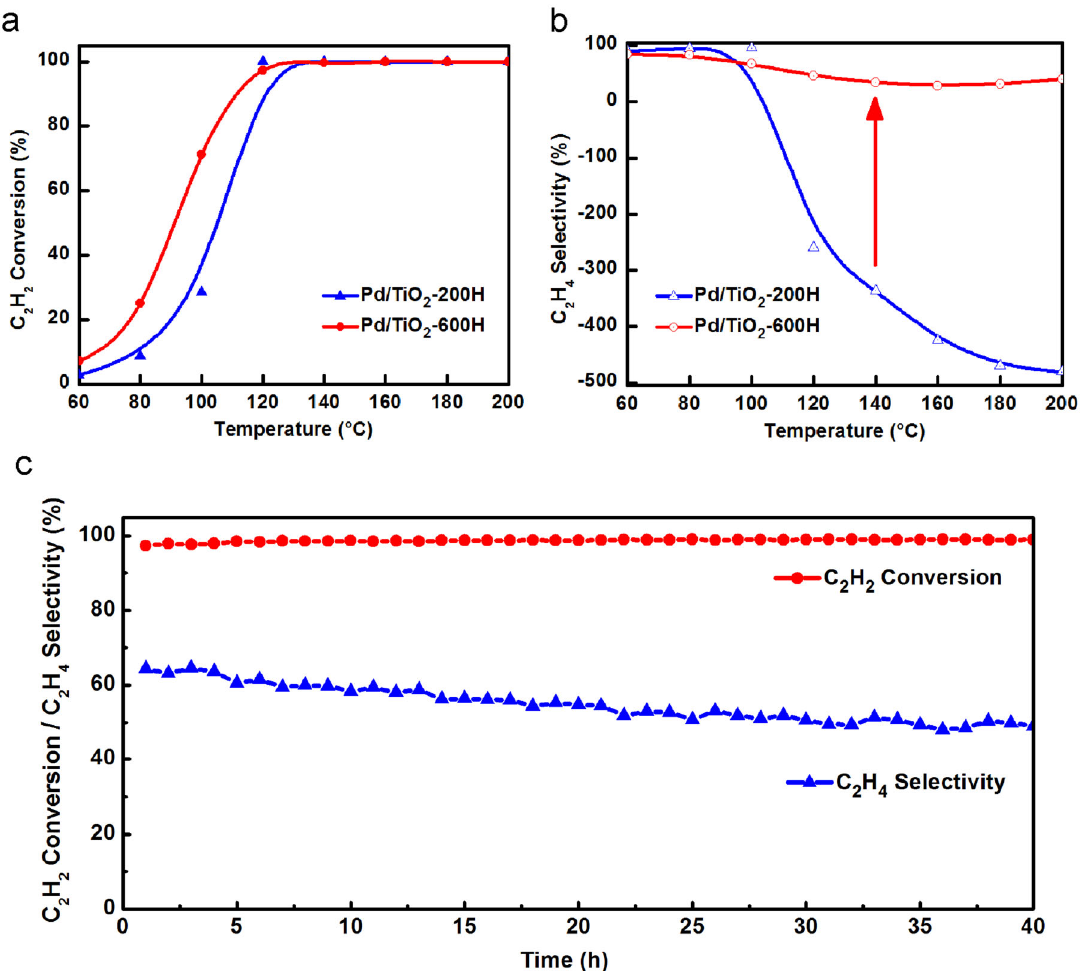
Fig. 3 Catalytic performance of Pd/TiO 2 serial catalysts. Acetylene conversion a and ethylene selectivity b as a function of temperature for acetylene semi-hydrogenation over Pd/TiO 2 -200H and Pd/TiO 2 -600H. c Durability test on Pd/TiO 2 -600H at 120 °C for 40 h. Reaction conditions: 1 vol% C 2 H 2 , 10 vol% H 2 , 20 vol% C 2 H 4 balanced with He; WHSV = 120,000 mL h − 1 g cat − 1